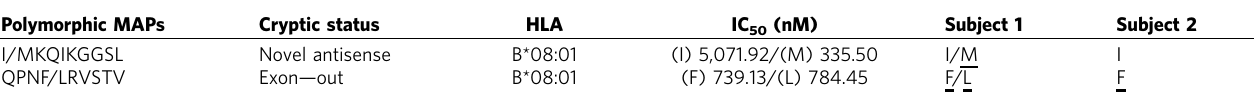
HLA, human leukocyte antigen; IC 50 , half-maximal inhibitory concentration; MAP, MHC class I-associated peptide; MHC, major histocompatibility complex; MS, mass spectrometry. The columns Subject 1 and Subject 2 indicate the peptide variant coded by transcripts found in each subject as well as a positive MS detection when the amino acid is